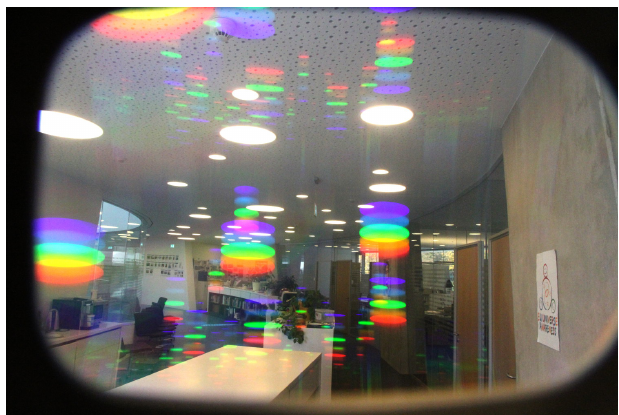
Fig. 16.— Light sources, imaged through a dispersive element (“spectral glasses”)